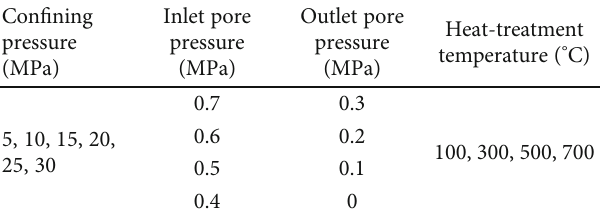
Table 2: Rock sample permeability test points.